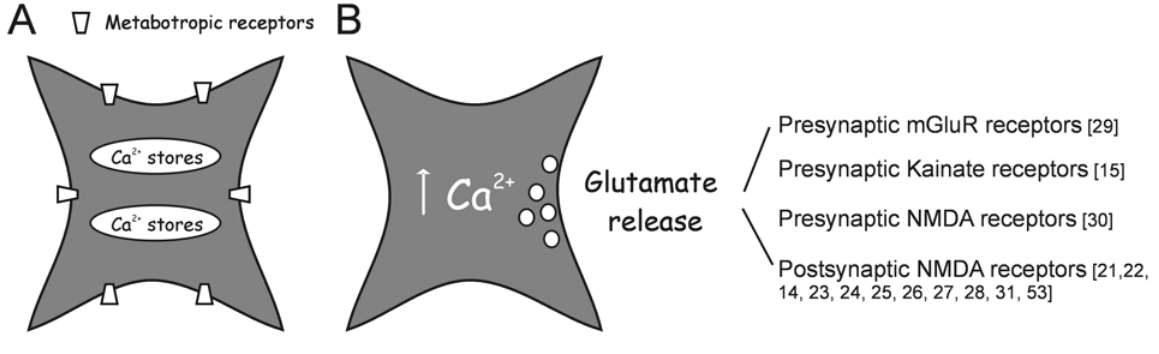
FIGURE 1 . Glutamate release from astrocytes in situ controls neuronal excitability. (A) Astrocytes express metabotropic receptors for different neurotransmitters in the plasma membrane. Activation of these receptors triggers Ca 2+ increases (B) within astrocytes due, mainly, to Ca 2+ release from intracellular stores. (B) These Ca 2+ oscillations stimulate the release of glutamate from astrocytes, which modulates neuronal excitability through the activation of a variety of different neuronal